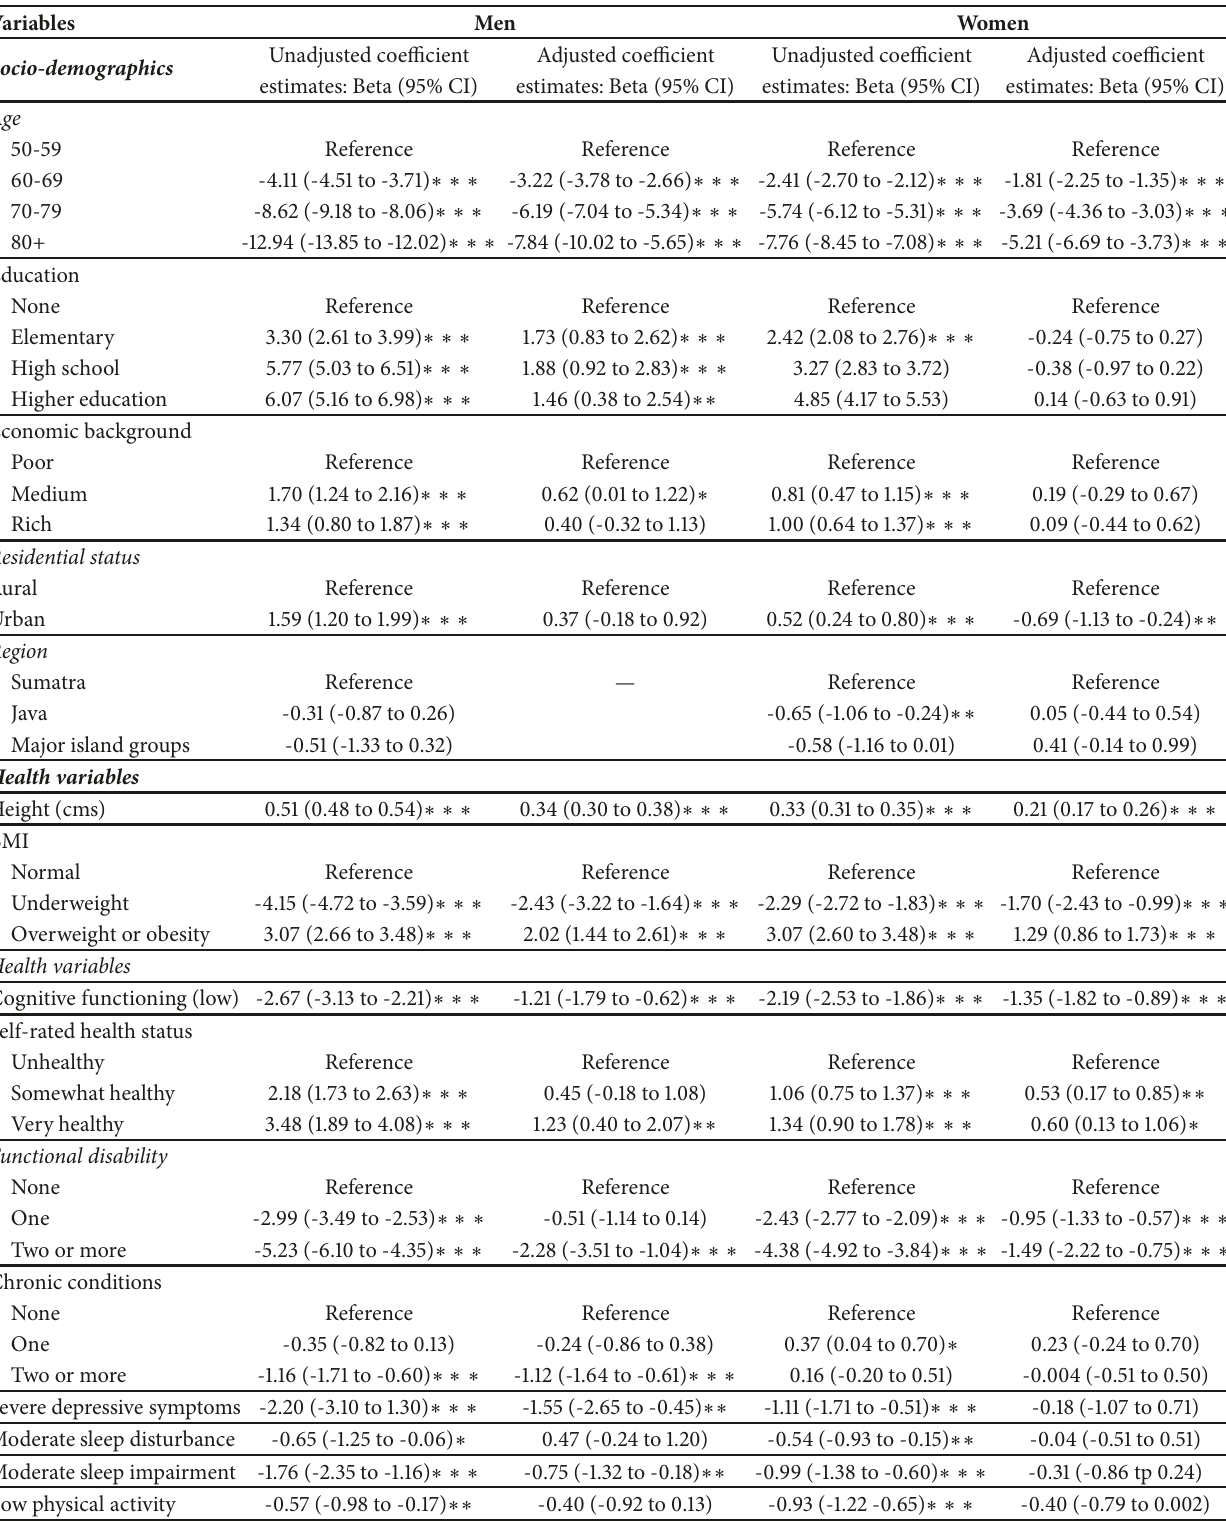
Table 2: Association of hand grip strength with socio-demographic and health variables among older adults in Indonesia by sex. Variables